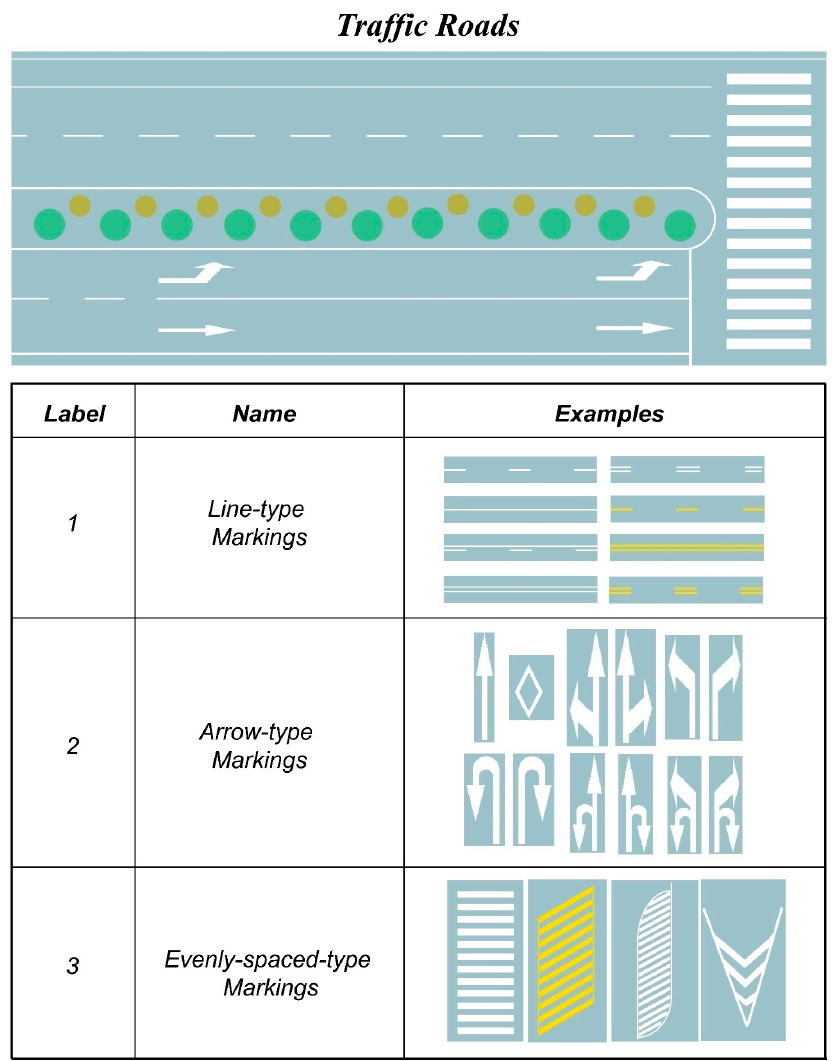
Figure 7. The classification system of pavement markings for segmentation by DeepLab V3+.